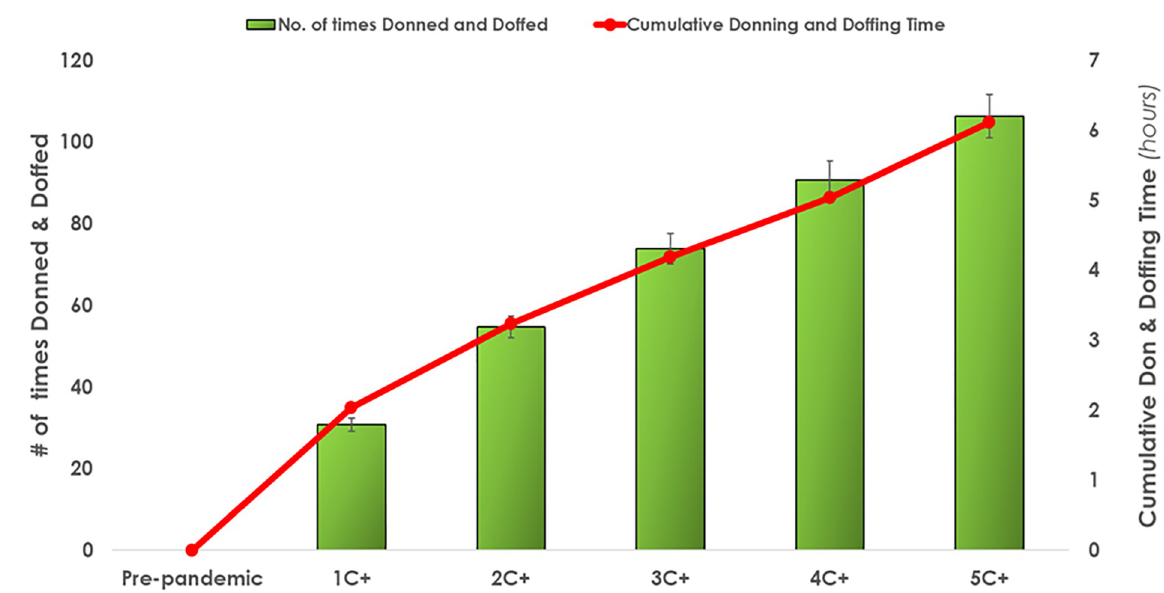
Fig 5. Average PPE donning and doffing frequency and cumulative time required in a single shift as COVID+ patients increased in a five-bed patient assignment. Error bars illustrate standard deviations. Table 3 provides a quantitative overview of the results.